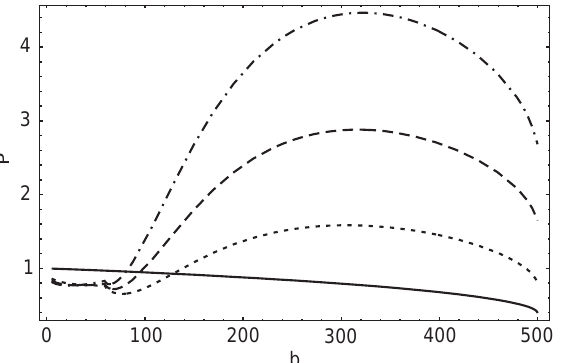
Fig. 6. Same as Fig. 3, but now displaying the potential drop model itself (Eq.